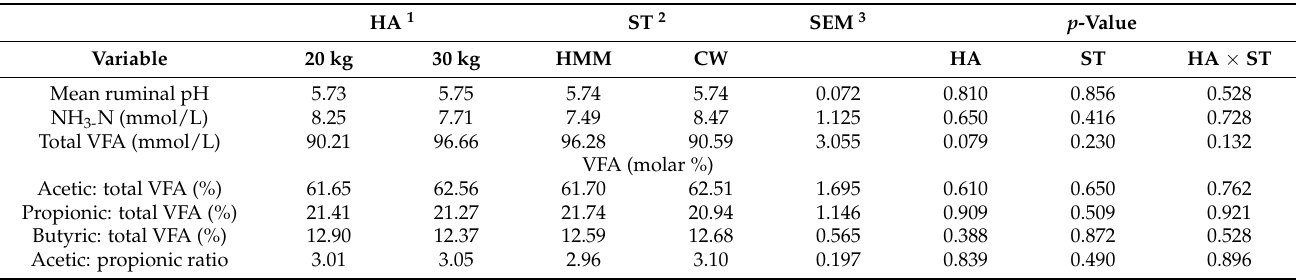
Table 4. Effect of herbage allowance and supplement type on ruminal functions of grazing dairy cows ( n = 4).